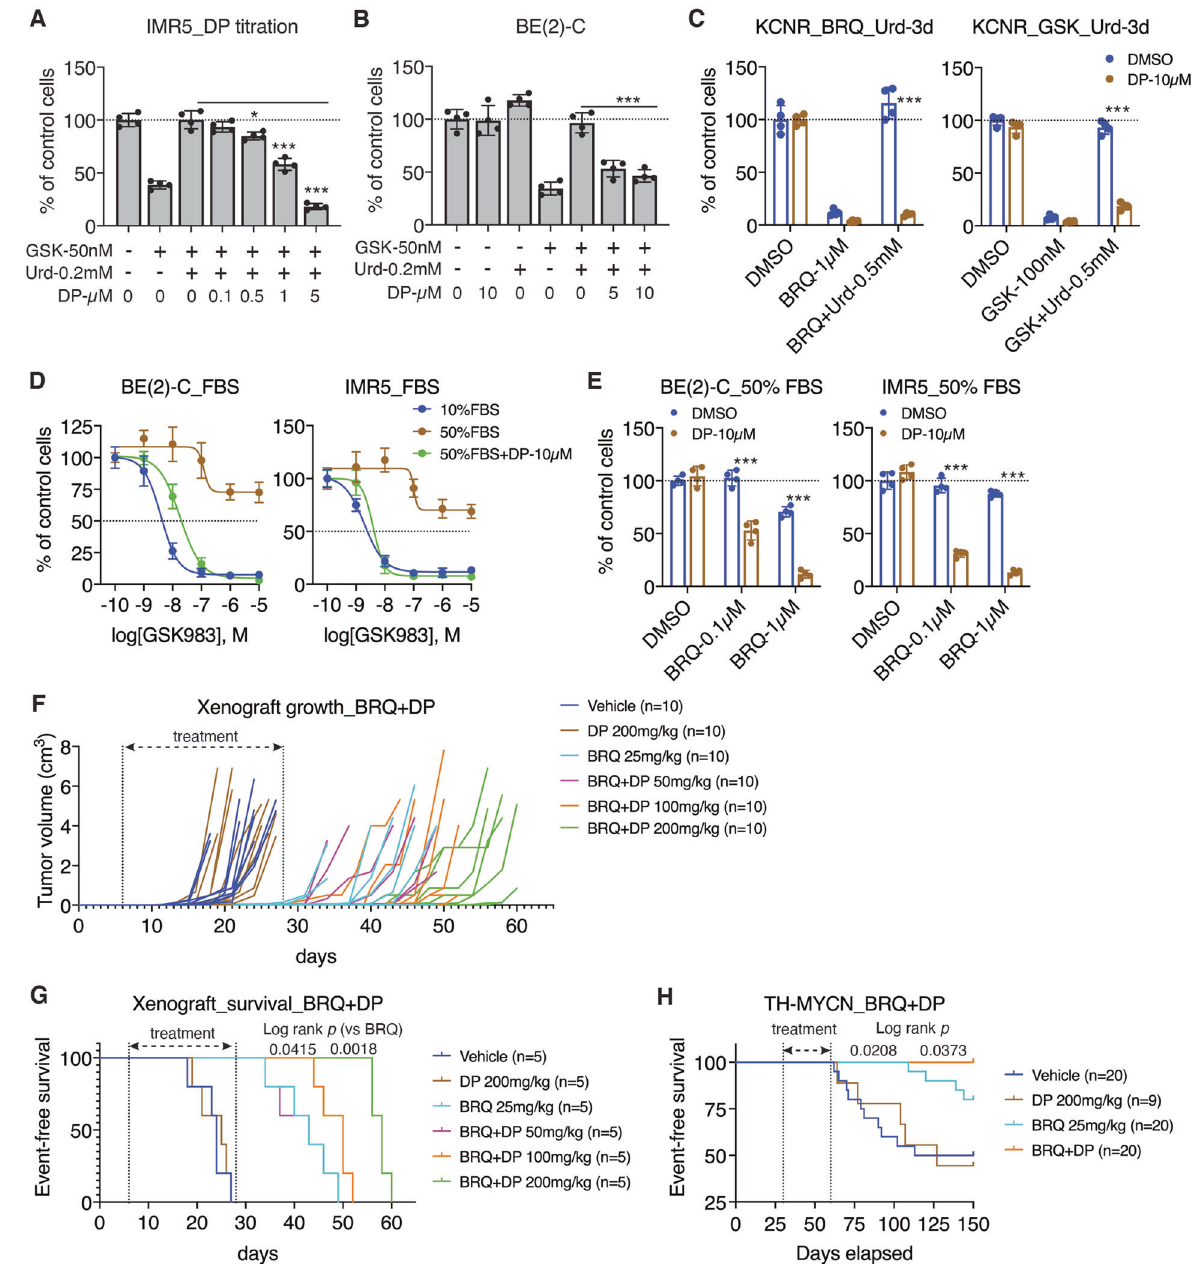
Fig. 6 Blocking nucleoside transport abrogates uridine-dependent resistance to DHODH inhibitors. A – C Cell-growth assay of the indicated cell lines treated with GSK983 or BRQ without or with supplemental uridine and dipyridamole (DP) for three days. Data are mean ± SD ( n = 4). P values were determined by two-tailed Student ’ s t -test. * P < 0.05, *** P < 0.001. D Dose – response curves for GSK983 in MYCN -ampli fi ed cell lines cultured in the presence of 10% or 50% FBS without or with dipyridamole for four days. Data are mean ± SD ( n = 4). E Cell-growth assay of MYCN -ampli fi ed cell lines cultured in media containing 50% FBS for four days of treatment with BRQ in the absence or presence of dipyridamole. P values were determined by two-tailed Student ’ s t -test. *** P < 0.001. F, G Tumor-growth ( F ) and event-free survival ( G ) curves for mice bearing BE(2)-C xenografts treated with vehicle, dipyridamole (daily), BRQ (every other day), or BRQ in combination with various concentrations of dipyridamole. Log-rank test P values are indicated for BRQ + D P 100 mg/kg and BRQ + DP 200 mg/kg vs. BRQ only. H Event- free survival curves for T H -MYCN mice treated with vehicle, dipyridamole (daily), BRQ (every other day), or BRQ plus dipyridamole. Log-rank test P values are indicated for BRQ only vs. vehicle or BRQ +